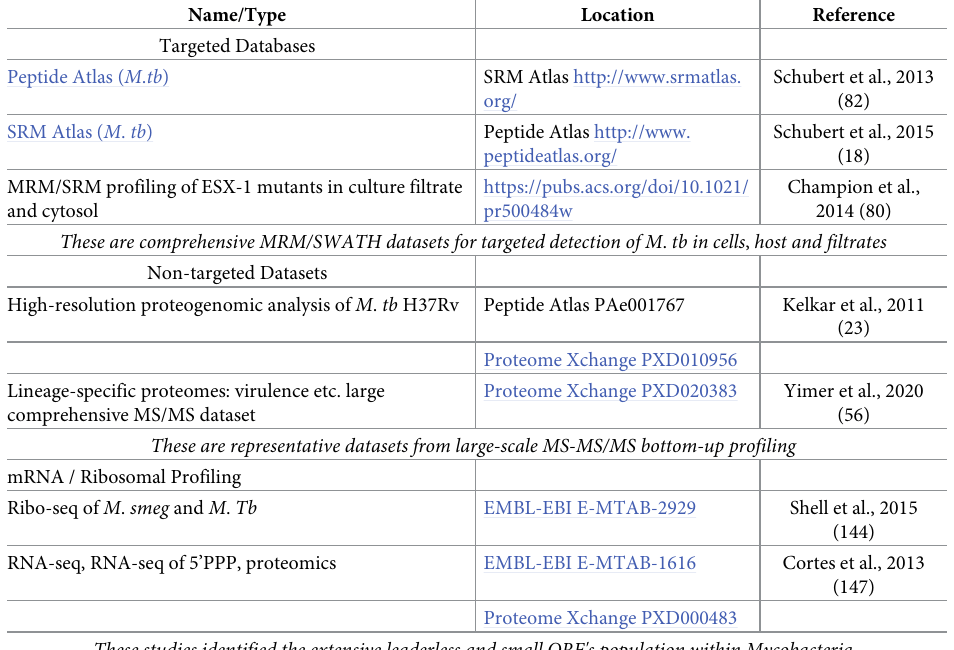
Table 1. Mycobacterial genetic proteome databases and